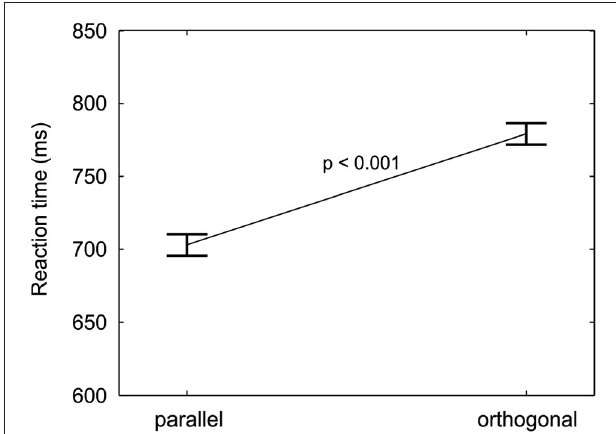
FIGURE 5 | Orientation anisotropy . RTs (mean and repeated-measures 95% confidence intervals, pooled across cue-location groups, location validities, and orientation validities) are plotted for the two target orientations. A significant decrease in reaction time from orthogonal to parallel targets is